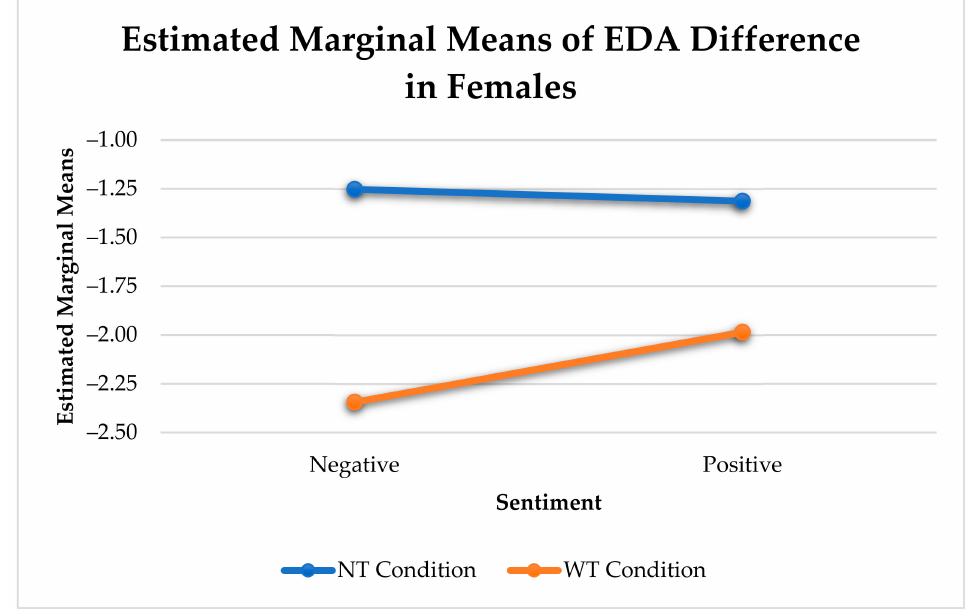
Figure 11. Differences in Physiological Arousal Change Elicited by Utterances with or Without Affective Touches for Positive and Negative Sentiment in